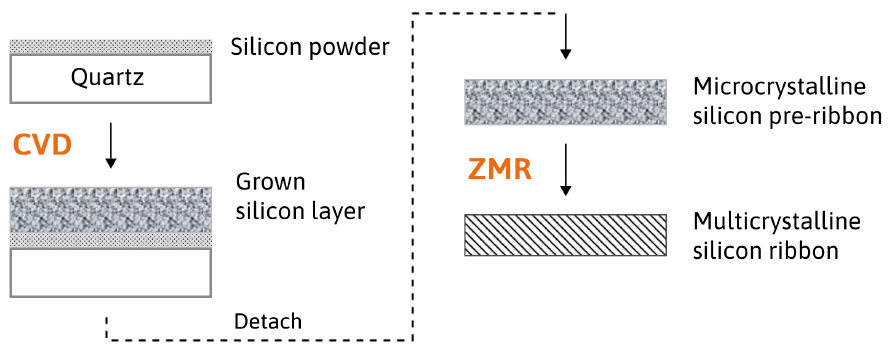
Figure 2. SDS experimental process diagram.